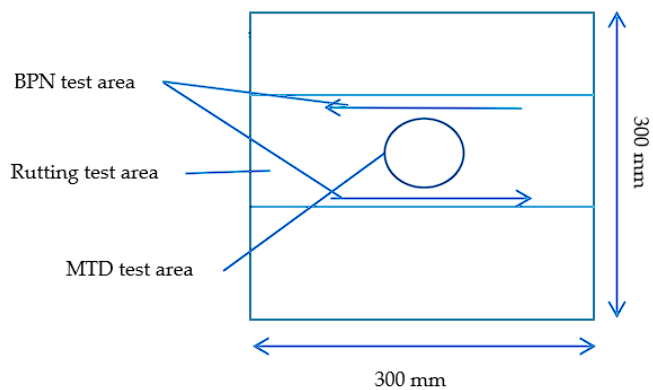
Figure 4. Experimental selection section.